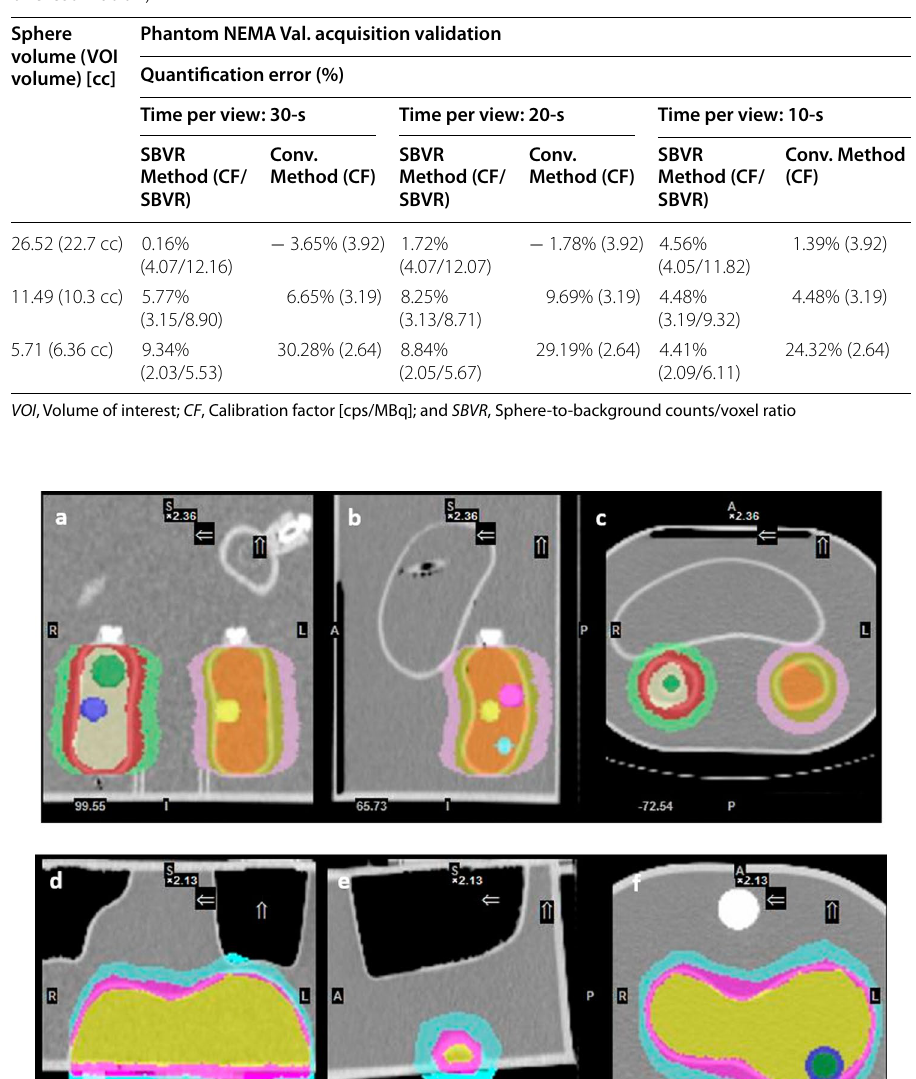
Table 3 Quantification errors between activity concentrations calculated with the conventional method and with the SBVR method for different time per view settings (minus sign – overestimation)